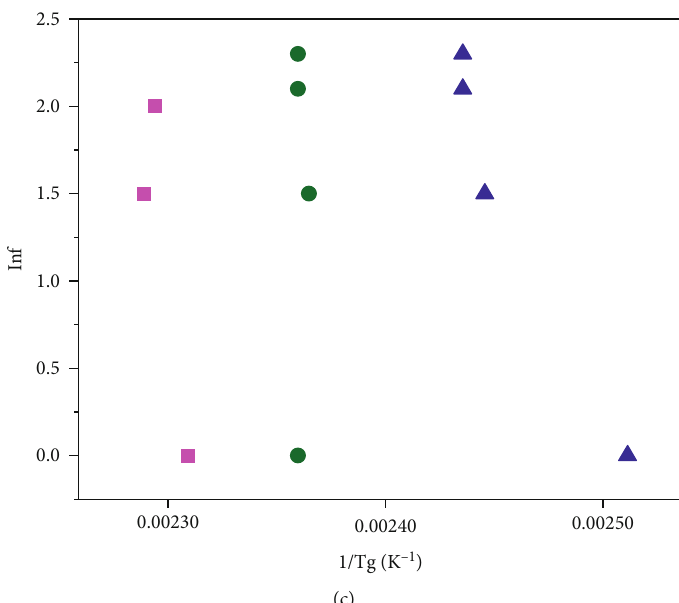
Figure 4: Circumferential composites have varying loss factors and Tg at variant frequencies. (a) Loss factor vs. frequency. (b) Tg vs. frequency. (c) Apparent activation energies of circumferential